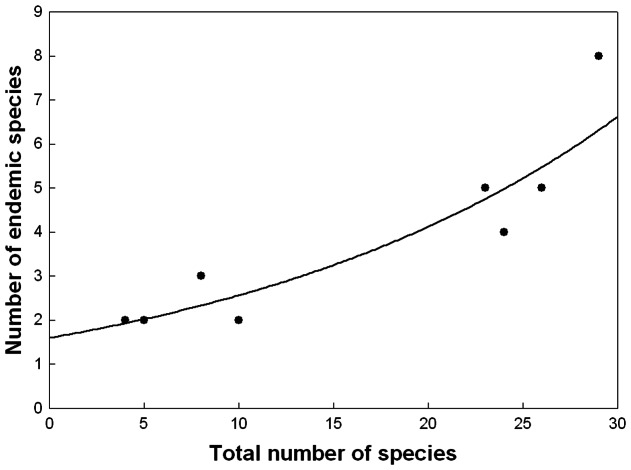
The relationship of ecoregional endemic with total phanaeine species richness.The curve represents a least squares exponential function.